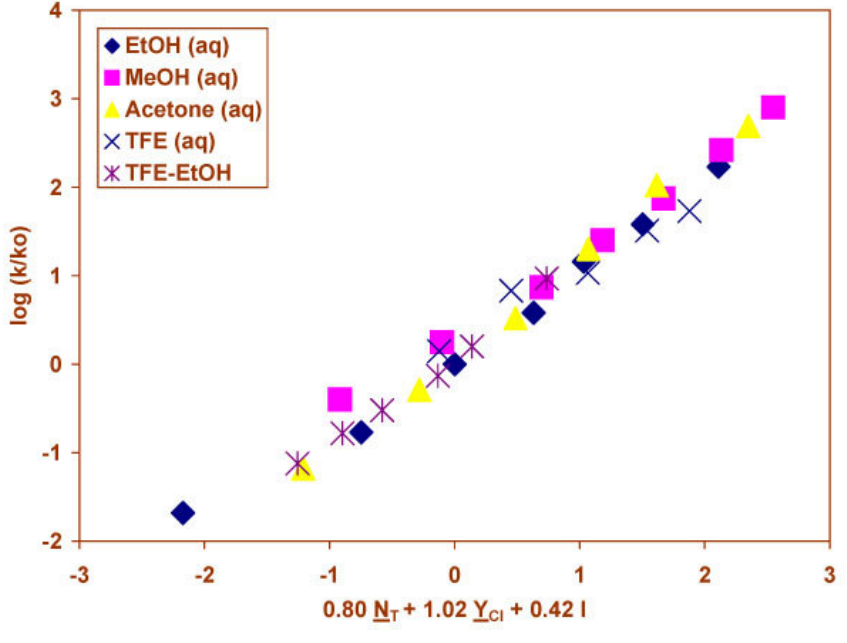
+ 1.02 Y + 0.42 I) for the solvolyses of phenyl T Cl